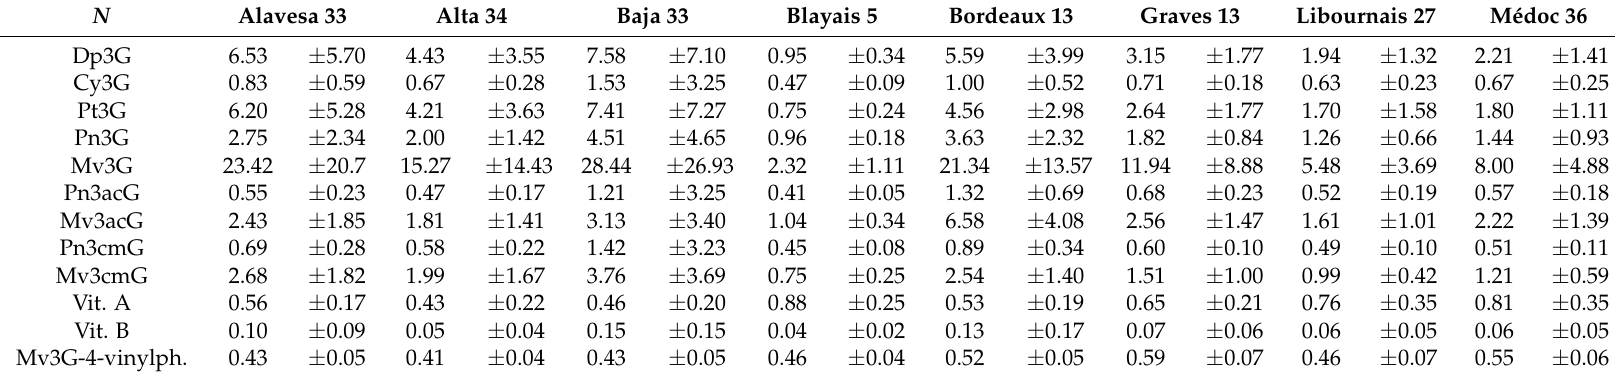
Table A1. Descriptive statistics of the anthocyanin and derived pigment contents for each wine region, expressed in mg/L in equivalent malvidin-3- O -glucoside.